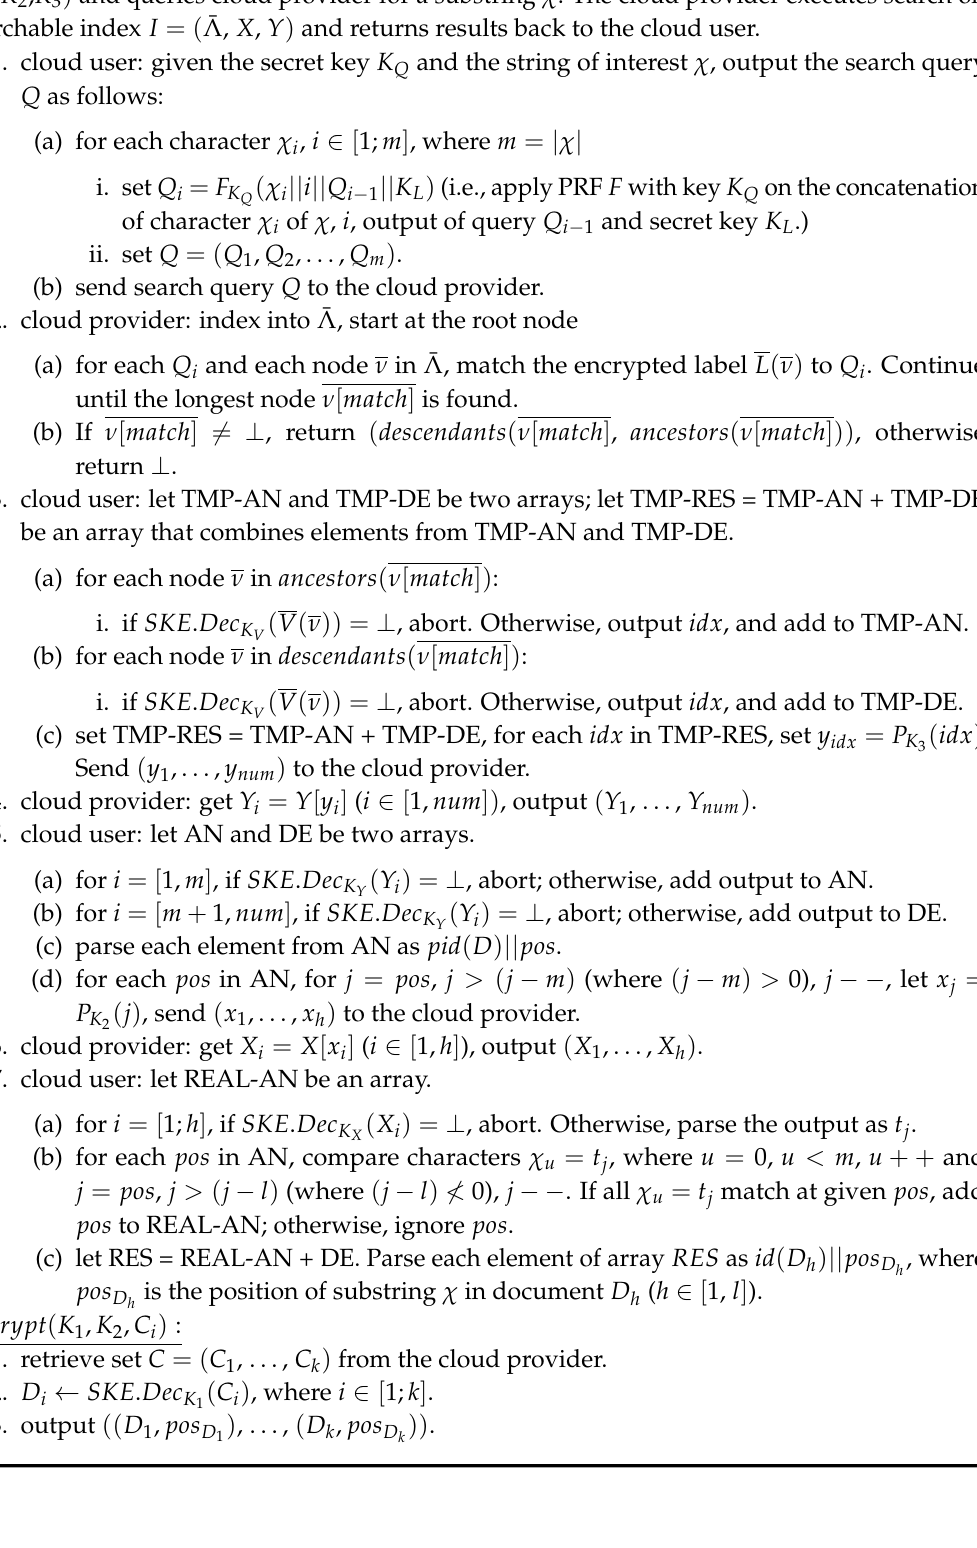
Algorithm 3 : SSP-SSE search phase. SEARCH